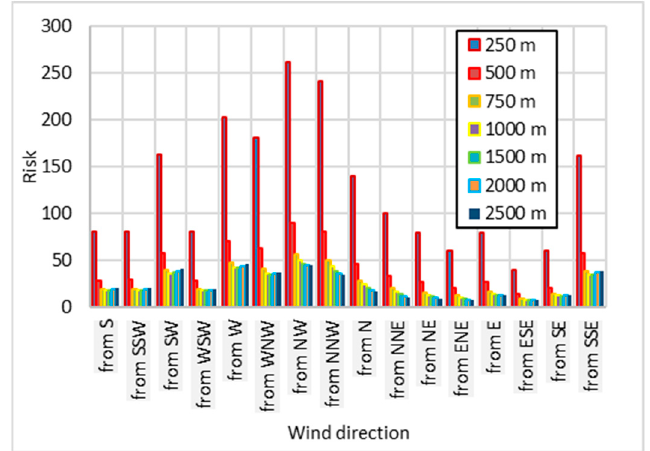
Figure 19. Risk of NO x air pollution as a function of wind direction, conditional on distancing, in a one ‐ year return period.